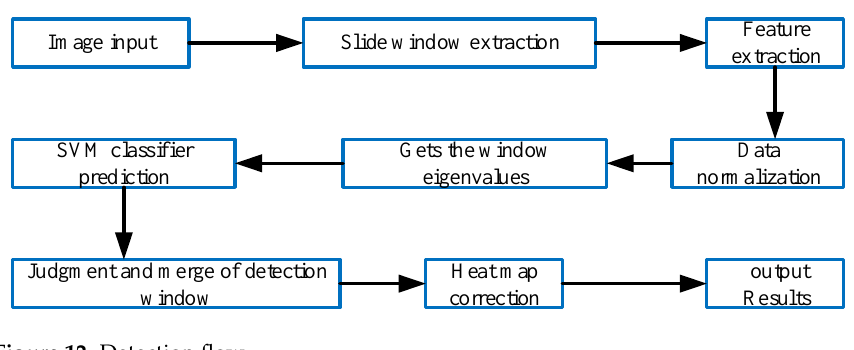
(d) Figure 11. Receiver operating characteristic curve (ROC) of the model. ( a ) HOG-ROC (area = 0.976), ( b ) LBP-ROC (area = 0.969), ( c ) Haar-ROC (area = 0.913), ( d ) multifeature-ROC (area = 0.992). The area enclosed by the curve is defined as AUC (area under curve). The larger the area of AUC, the better the effect of the classifier. According to the above experimental results, the AUC enclosed by LBP, HOG, Haar-like, and multifeature ROC was 0.969, 0.976, 0.913, and 0.992. The results show that the multifeature fusion-classifier model has a relatively excellent classification performance. 2.4. Experimental Test and Results